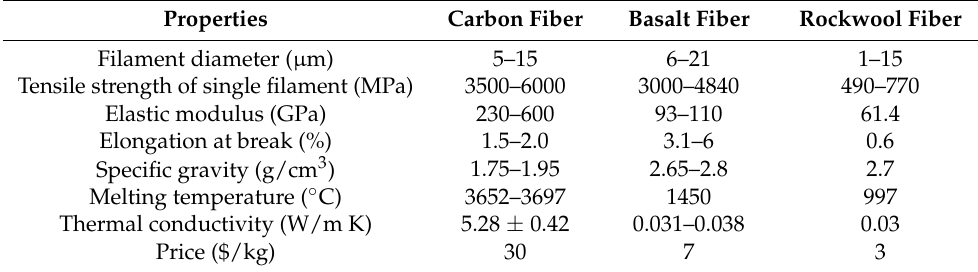
Table 1. Physical, mechanical, and thermal properties of fibers are included in the study [40,41].